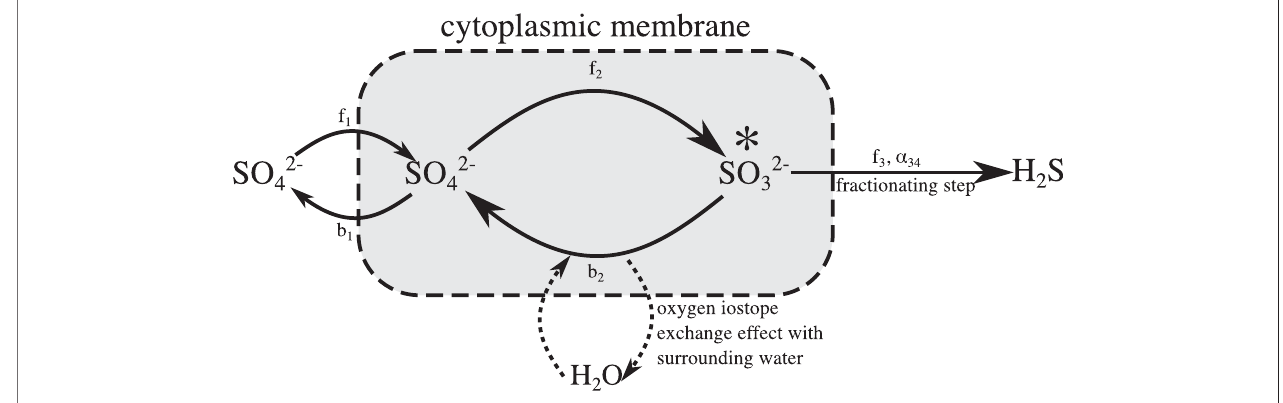
FIGURE 1 | Simpli fi ed sulfate reduction mechanism used in our model. We have combined steps 2, 3, and 4 described in the text into a single internal reduction step. All of the fractionation factors have been combined into a single overall sulfur fractionation factor in the fi nal step, now made irreversible. The rate of oxygen exchange with the ambient water is tied to the reversibility of the single overall reduction step, as detailed in the text body.